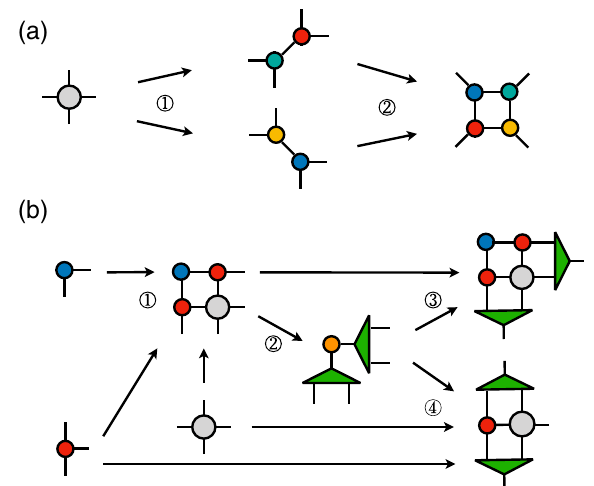
FIG. 2. (a) The iteration step of TRG. (b) The iteration step of CTMRG. Each tensor is a node in the computation graph. The primitive functions in the computation graphs are SVD and tensor